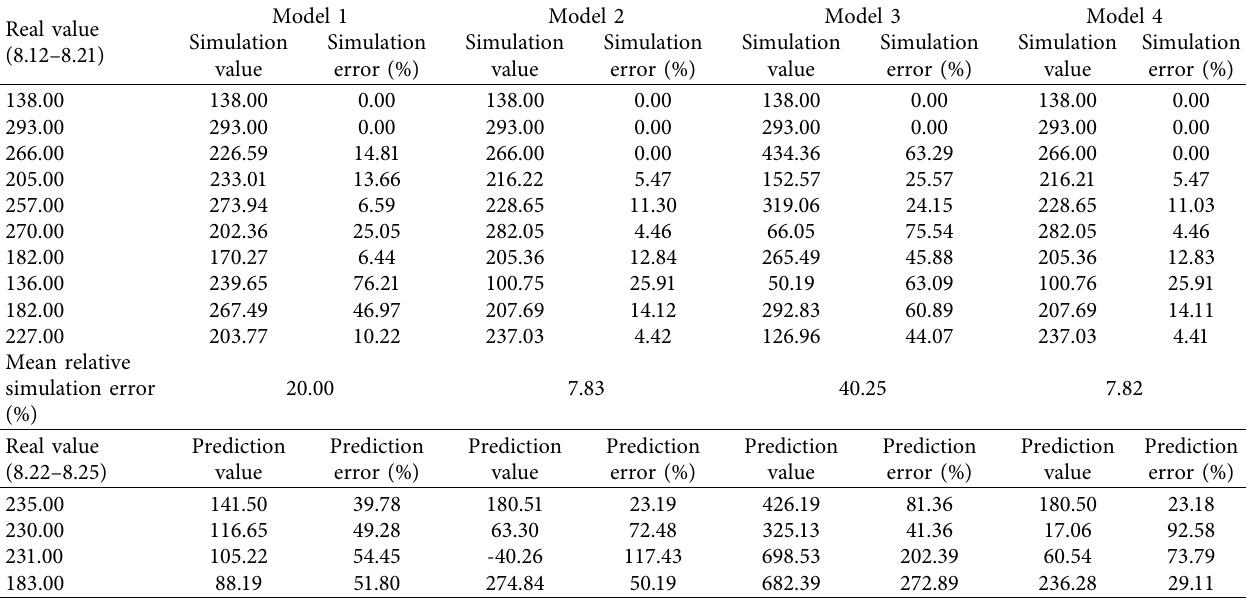
Table 3: Comparison of the simulated predictions of the four models on short-time trafc fow.